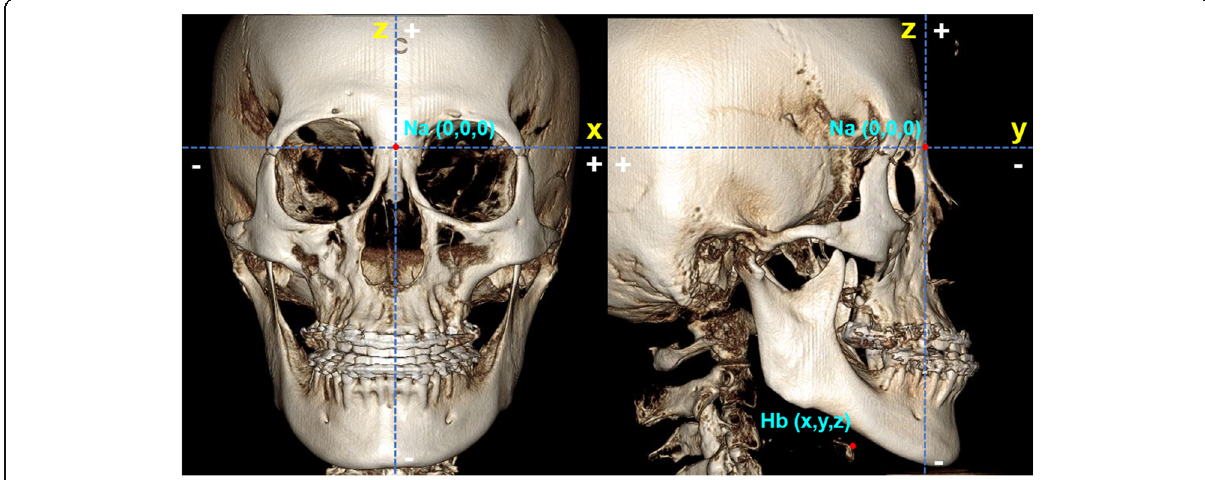
Fig. 1 The plus and minus values along the three axes used in this study. The coordinates of the landmarks were assigned according to nasion (0, 0, 0). For the x -axis, landmarks on the left side are (+) values and the right side ( − ) values. For the y -axis, landmarks located posterior to the nasion are (+) values and anterior to the nasion ( − ) values. For the z -axis, landmarks located superior to the nasion are (+) values and inferior to the nasion ( − ) values. The coordinates of the Hb point are identified in T0 and T1 CBCT